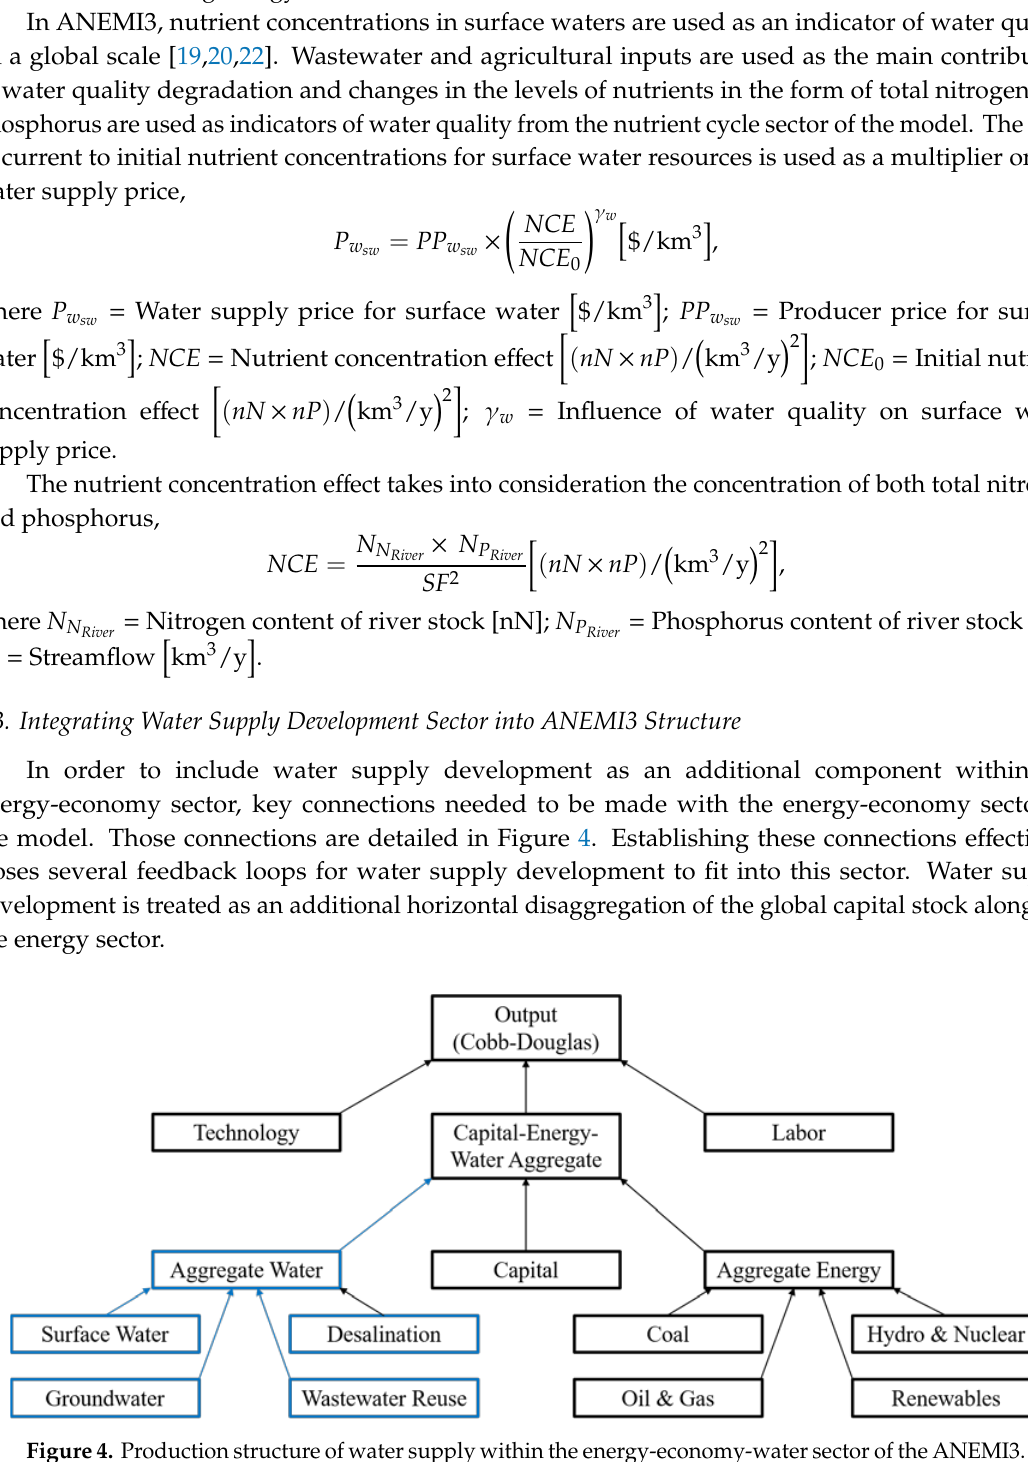
Figure 4. Production structure of water supply within the energy-economy-water sector of the ANEMI3.